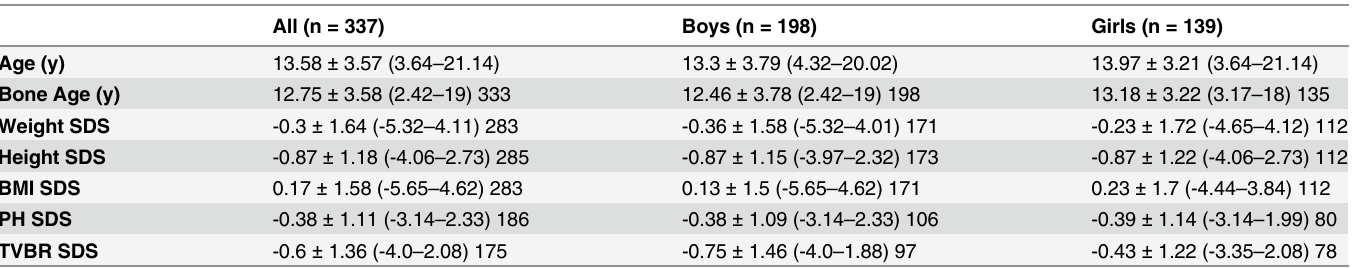
Mean ± SD and range (in parentheses) are displayed, followed by the number of patients examined for the following parameters: age (in years), bone age (in years) assessed using the method of Greulich and Pyle, weight SDS, height SDS, body mass index SDS (BMI SDS), pubic hair stage SDS (PH SDS) and testicular volume/breast development stage SDS (TVBR